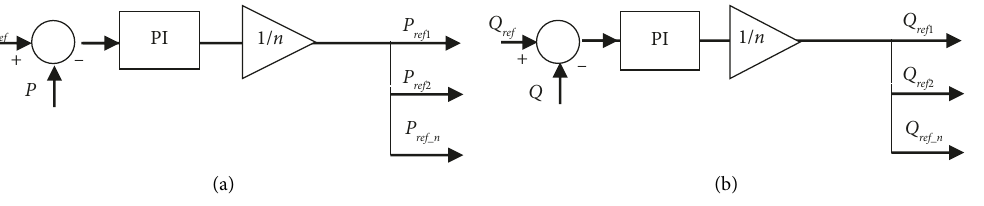
Figure 5: Proposed control scheme for the wind farm.